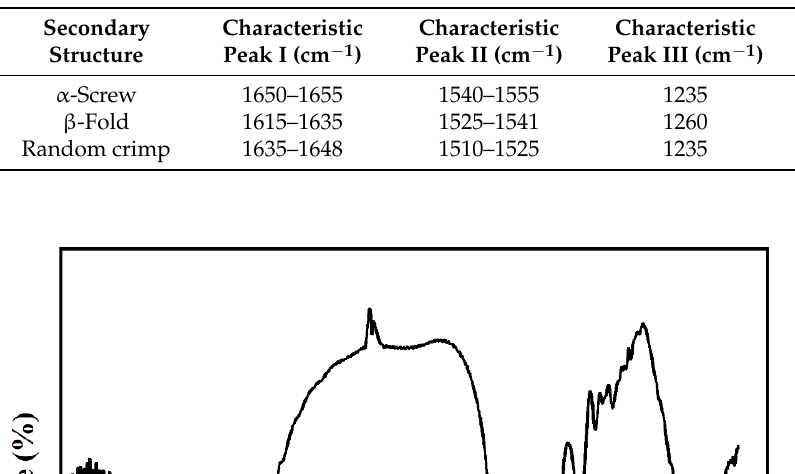
Table 1. Infrared characteristic peaks and secondary structure relationship table.